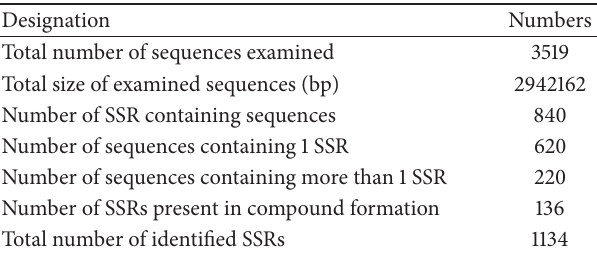
Table 1: Results of microsatellite